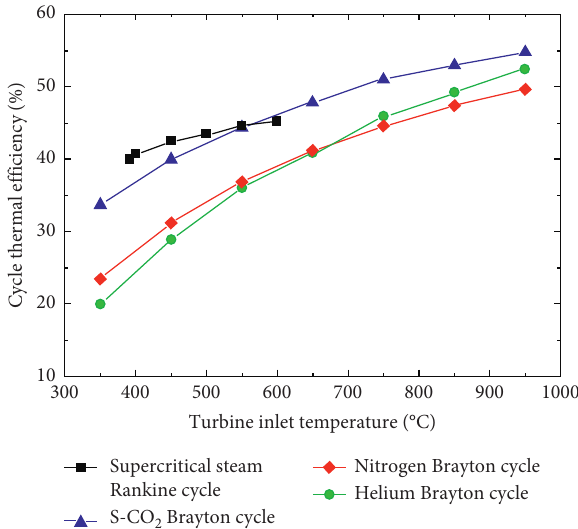
Figure 2: Power cycle efficiency comparison between different power conversion systems.